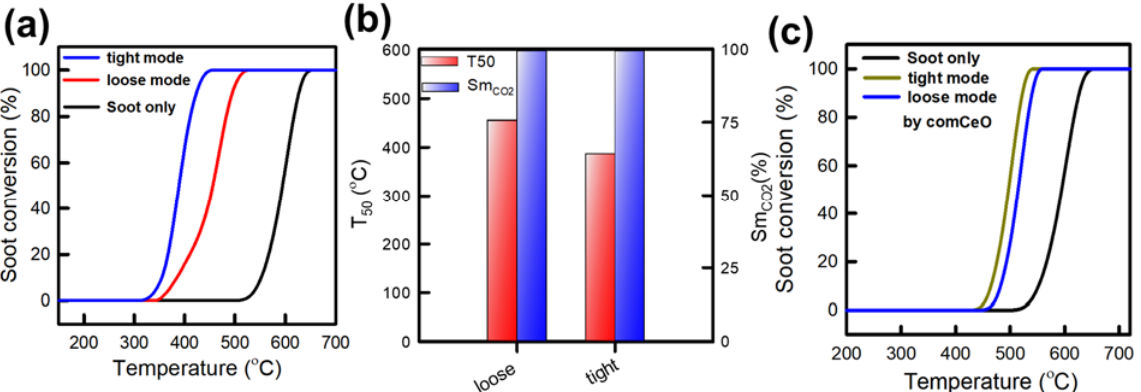
Figure 9. Soot oxidation by CeONB under the loose contact and tight contact modes: ( a ) soot conversion (%), ( b ) T 50 and S mCO2 , and ( c ) soot oxidation by comCeO under the loose contact and tight contact modes.